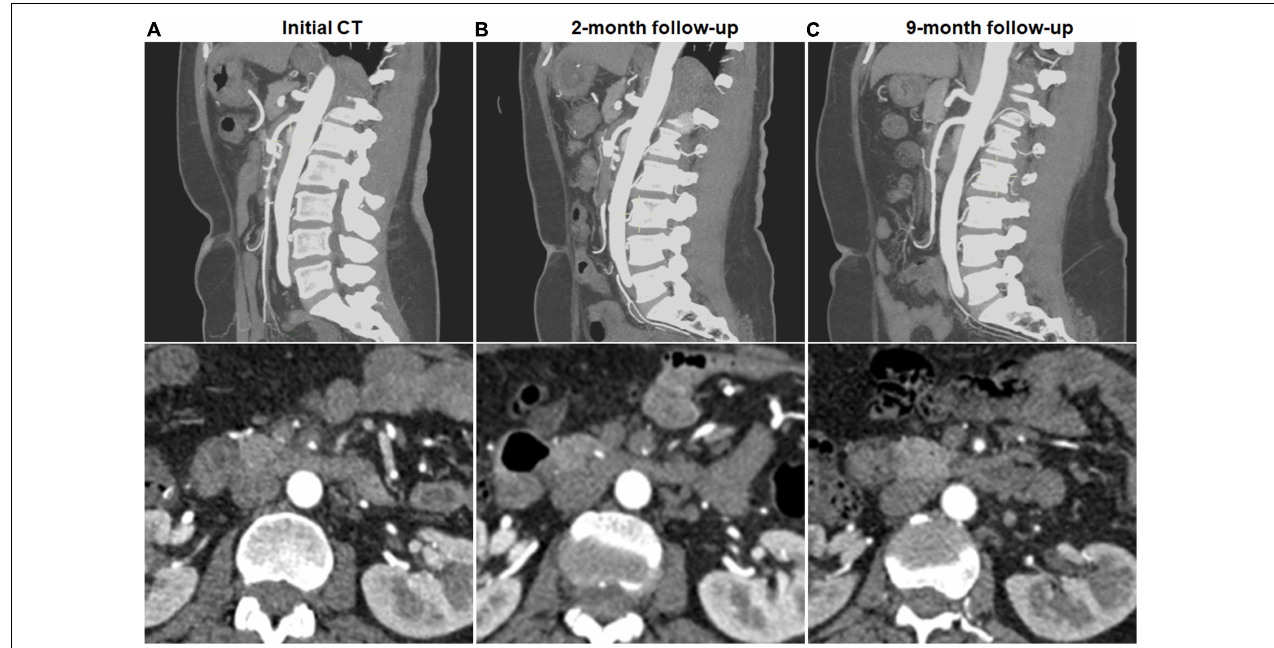
FIGURE 2 | Complete remodeling of type III spontaneous isolated superior mesenteric artery dissection on follow-up computed tomography (CT) angiography. (A) Initial CT angiography showed the thrombosed false lumen with ulcer-like projection (ULP) in a 52-year-old woman. (B) Two months later, stenosis of true lumen was aggravated with thrombosis of false lumen and ULP. (C) Nine months later, ULP disappeared and thrombosis in the false lumen was completely resolved.